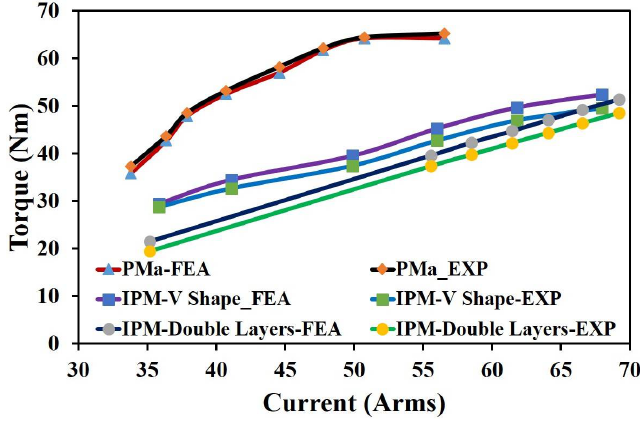
Figure 25. Torque comparison of IPMSMs and PMa-SynRM.